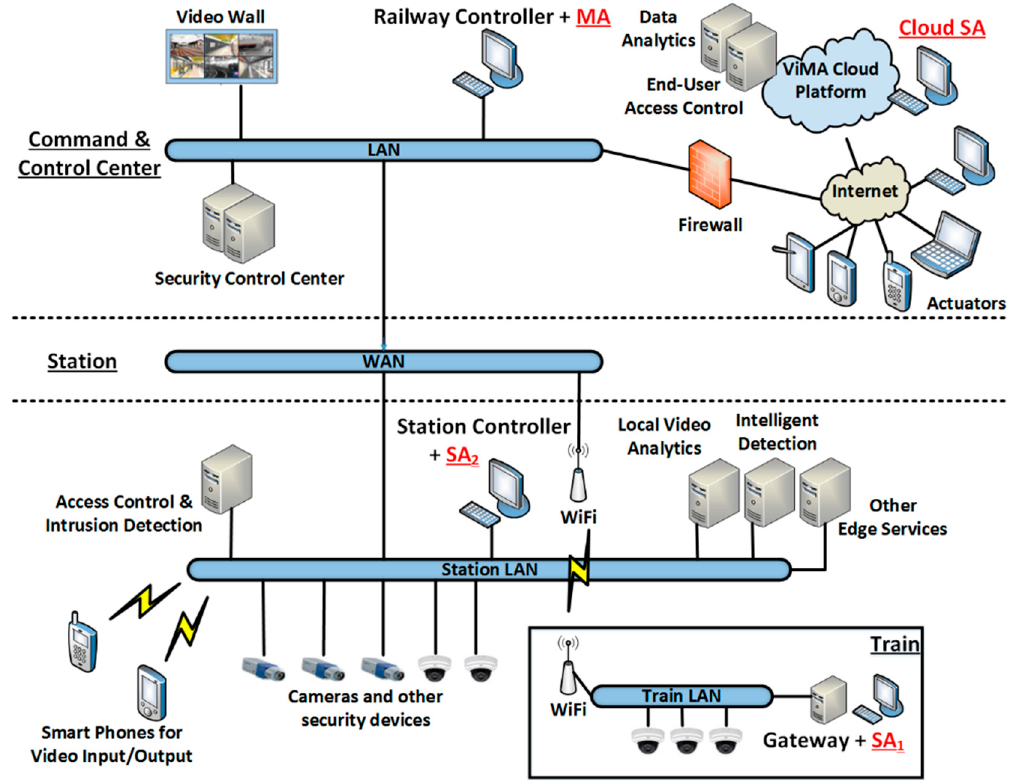
Figure 4. The smart railway use case architecture.